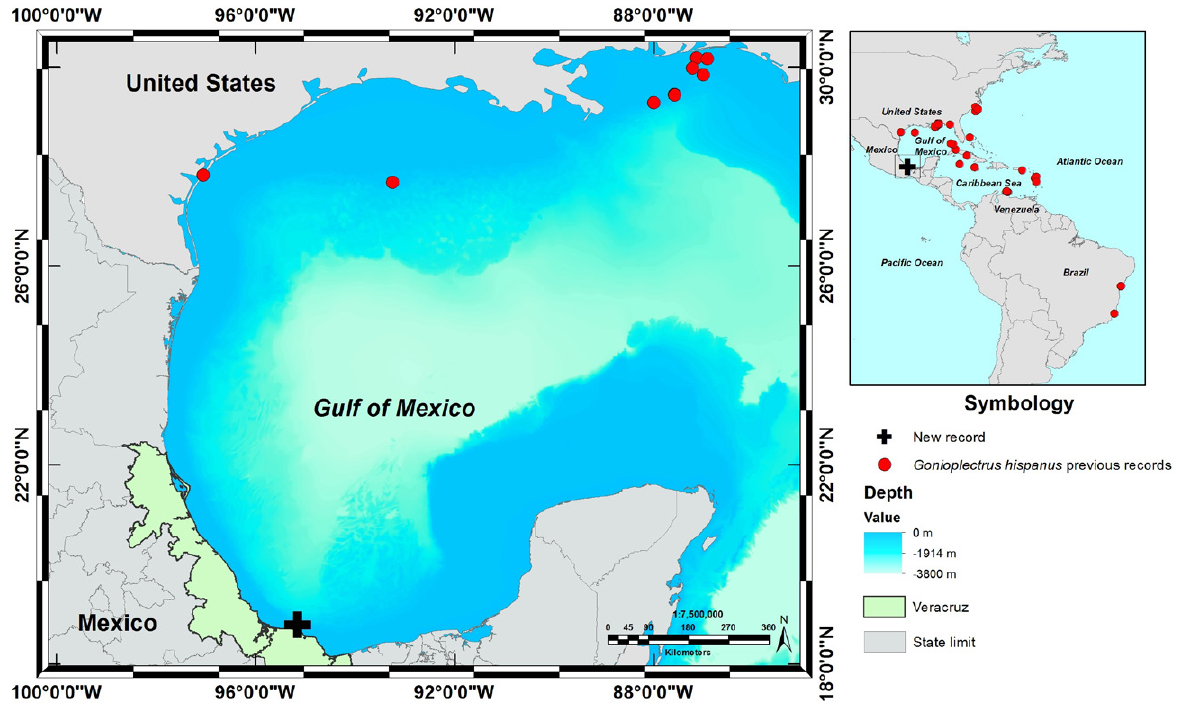
Figure 1. Sampling station of Gonioplectrus hispanus (black cross), ca. 11.8 km from Punta Puntilla, municipality of Ángel R. Cabada, Vera- cruz, south-western Gulf of Mexico (18°46 ′ 56.7 ″ N, 095°09 ′ 40.2 ″ W). Previous records of G. hispanus in the western Atlantic (red